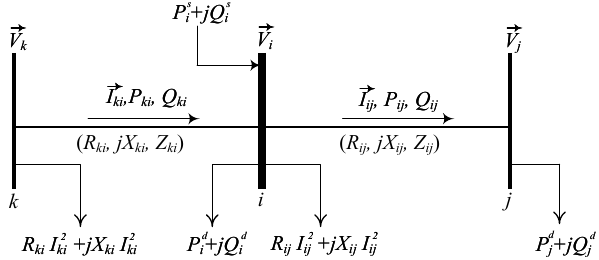
Figure 1. Illustrative example of circuits and loads in an EDN. Equation (4) takes into account the voltage drop in each circuit ij . Voltage magnitudes are computed using the power flow through the circuit and its electrical parameters. The authors in [65] suggested to eliminate the voltage angle to obtain Equation (4). In this case, V i represents the voltage magnitude at bus i (kV) and Z ij is the impedance of circuit ij . Equation (5) relates the square of current times the square of voltage, as well as the active and reactive power flows in each circuit ij . Constraints (6) and (7) limit the voltage in buses i and the current through circuits ij , respectively. In this case, V i and V are the upper and i lower voltage limits at bus i (kV), while I ij and I ij are the the upper and lower current limit of circuit ij (A),